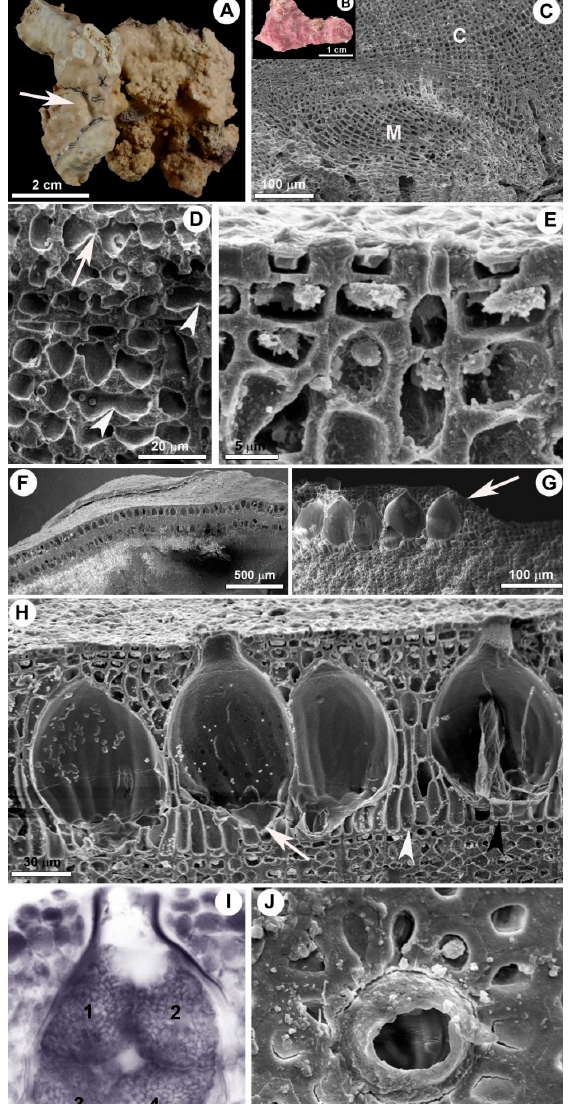
Figure 3. Sporolithon franciscanum sp. nov. holotype (RB 797665) and paratype (GM AF5). ( A ) Habit of holotype; scale bar = 2 cm. ( B ) Habit of paratype; scale bar = 1 cm. ( C ) Scanning electron micrograph (SEM) of a vertical section of the thallus showing the monomerous, plumose (non-coaxial) construction, with medullary (M) and cortical (C) filaments; scale bar = 100 µ m. ( D ) SEM of a vertical section showing a secondary pit connection (arrow) and a cell fusion (arrowhead) in the same thallus; scale bar = 20 µ m. ( E ) SEM view of the upper portion of the thallus showing flared epithallial and square to rectangular subepithallial cells; scale bar = 5 µ m. ( F ) SEM view of the thallus showing tetrasporangial compartments buried in a distinct layer; scale bar = 500 µ m. ( G ) SEM view of the upper portion of the thallus showing tetrasporangial chambers raised, 3–5 cells (including epithallial cells), above the surrounding thallus surface; scale bar = 100 µ m. ( H ) SEM view of the upper portion of the thallus showing the paraphyses (white arrowhead) between tetrasporangial chambers, a tetrasporangia subtended by a single stalk cell (arrow) and chambers with a basal layer of elongated cells (black arrowhead); scale bar = 30 µ m. ( I ) Vertical section showing a cruciately divided tetrasporangia (1–4); scale bar = 15 µ m. ( J ) SEM view of a tetrasporangial chamber pore and the surrounding rosette cells; scale bar = 10 µ